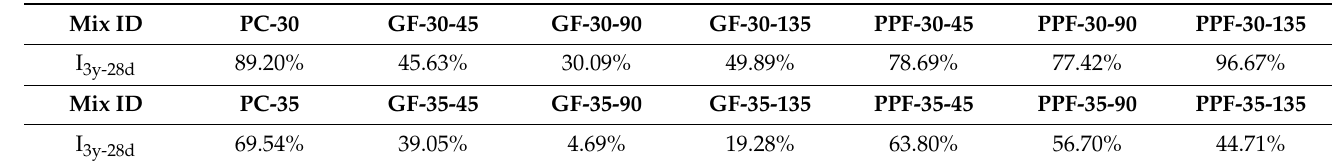
Table 8. The rate of increase of the three-year compressive strength of concrete relative to the 28-day compressive strength.